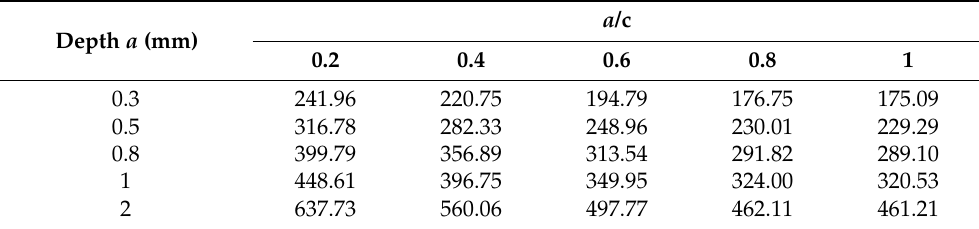
Table 2. Calculation results of the maximum of K I ( K I_max /MPa · mm 1/2